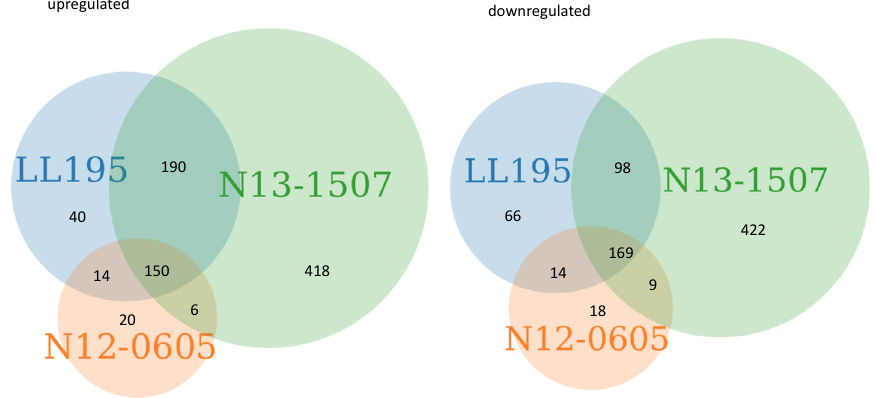
Figure 1. The number of genes that were up- and downregulated per strain in response to HCl acid shock at pH 3.